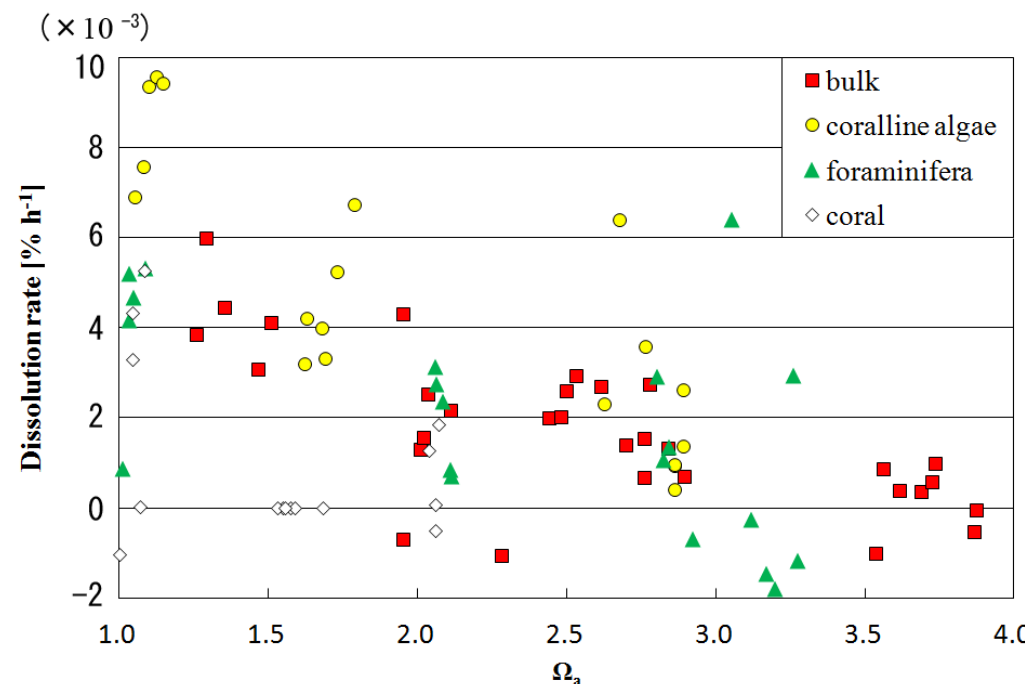
Fig. 7. The relation between average dissolution rate and (cid:127) a (all